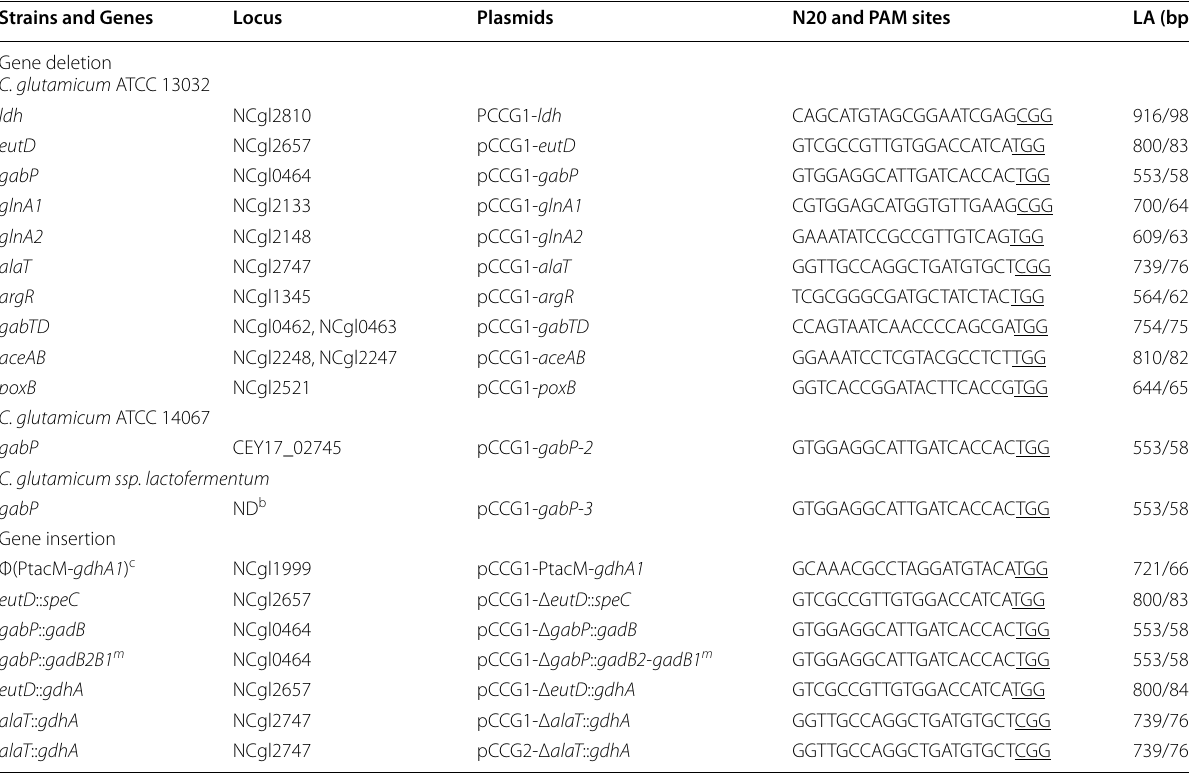
a, LA: the length of homologous arms (bp), which is the up and down homologous sequence flanking the deletion target sequence; b, ND: no data; c, Using the strong promoter PtacM and artificial RBS (GAA AGG ACT TGA ACG) sequence to replace the native promoter of gene gdhA1 in genome